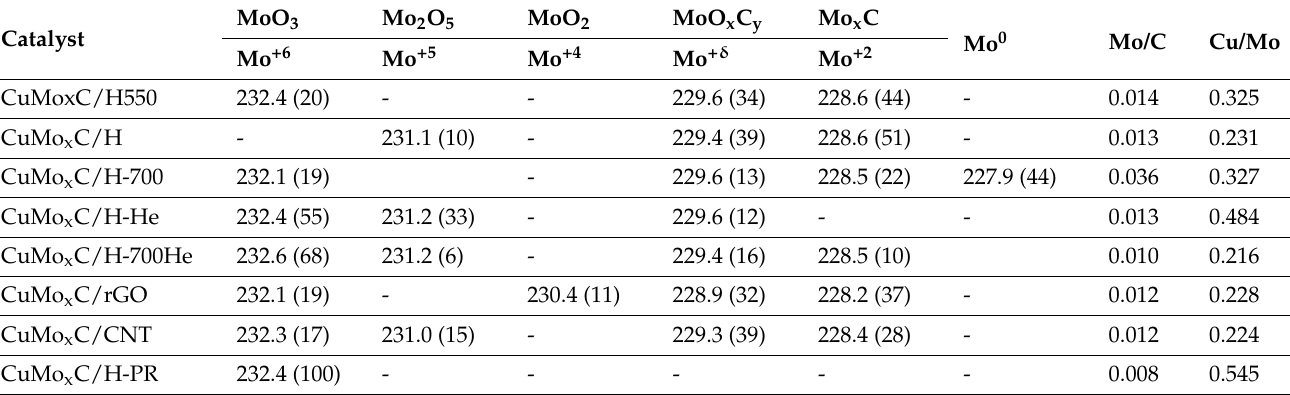
Table 1. XPS Binding energies (eV), concentration of species in brackets and atomic